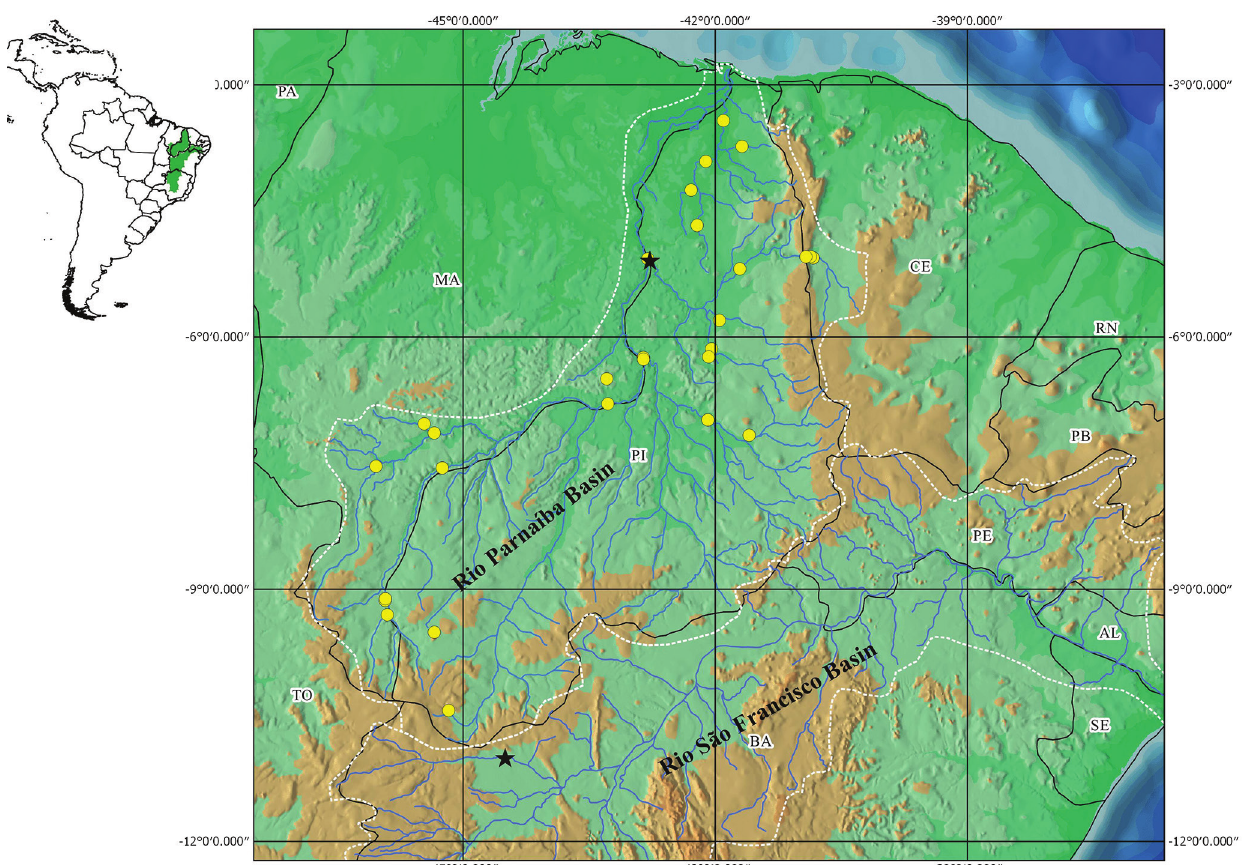
Fig. 3. Geographic distribution of Hypostomus johnii in the rio Parnaíba and São Francisco basins, Northeastern Brazil. Black stars indicates the type locality as Steindachner, 1877 (rio Poti, Teresina, Piauí, Brazil) and rio Preto, Vila de Santa Rita (currently municipality of Santa Rita de Cassia, Bahia,